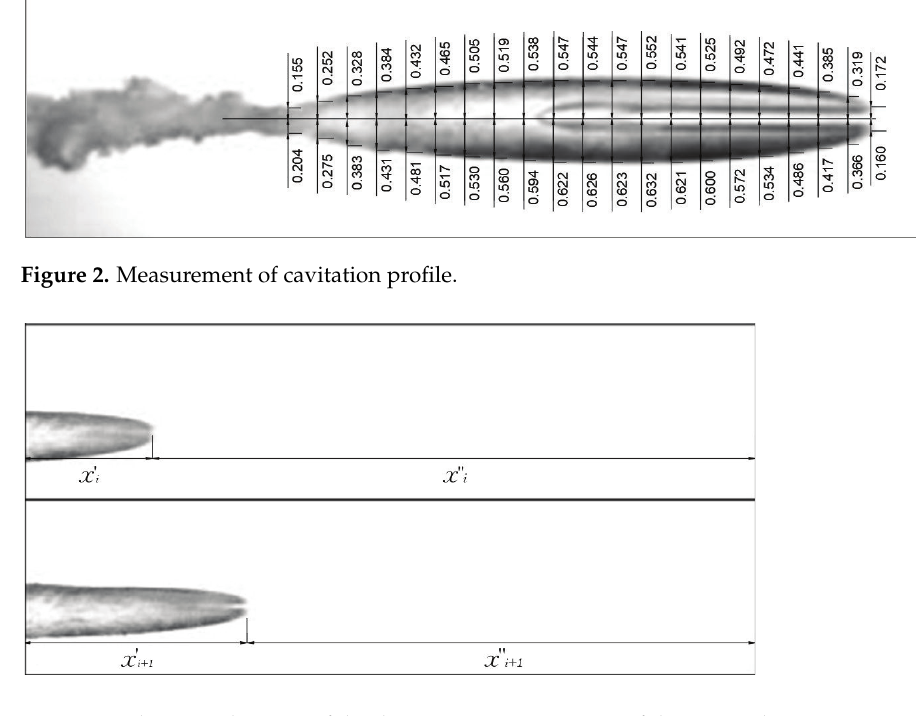
Figure 3. Schematic diagram of displacement measurements of the